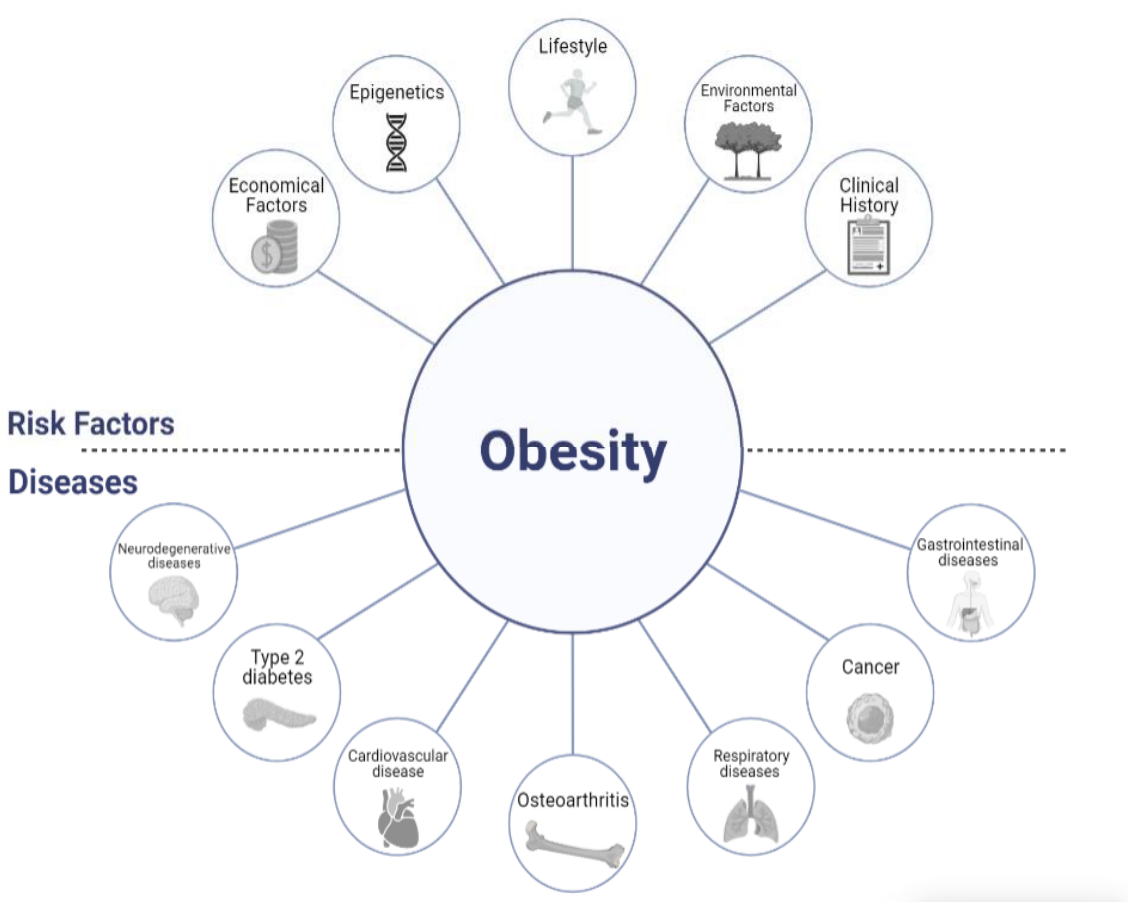
Figure 1. Risk factors and diseases associated to